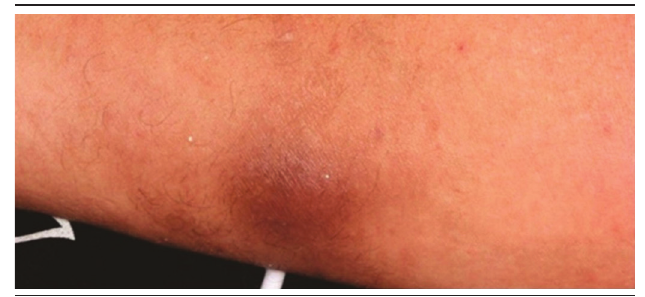
figurE 4 − Complete regression of the skin lesion after 11 months of treatment with antiretroviral therapy, with only an area of hyperpigmentation remaining